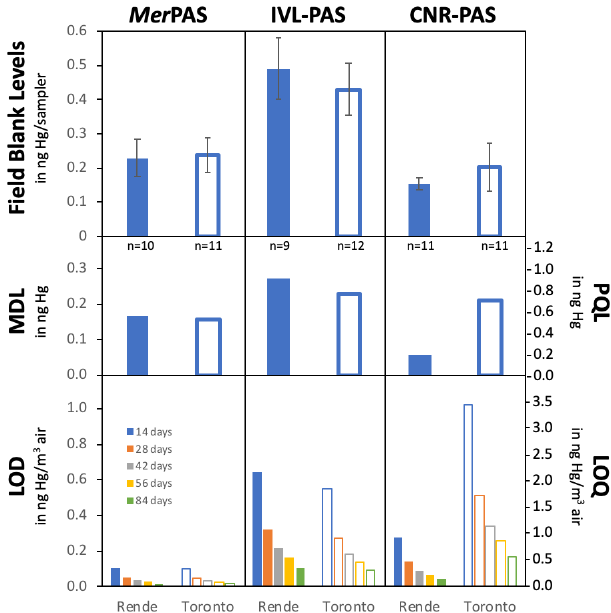
Figure 1. Mean and standard deviation of field blank levels, method detection limit (MDL), practical quantification limit (PQL), limit of detection (LOD), and limit of quantification (LOQ) for the three passive air samplers deployed in Rende, Italy, and Toronto,